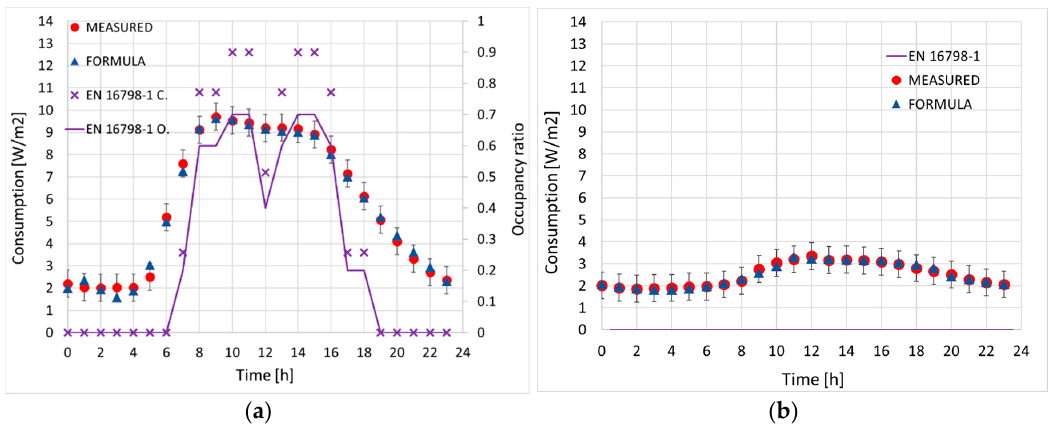
Figure 19. February measurements vs. correlation formula as in Table 4: ( a ) weekdays; ( b ) weekend. The plot in Figure 19 also features purple crosses, i.e., the hourly consumption computed according to the occupancy profile (solid purple line) of the EU Standard EN 16798-1 [25]. The Standard estimates 12 W / m 2 for lighting and 6 W / m 2 for occupancy, neglecting the weekends completely and assuming null occupancy throughout. We thus conclude that in this case one cannot infer energy